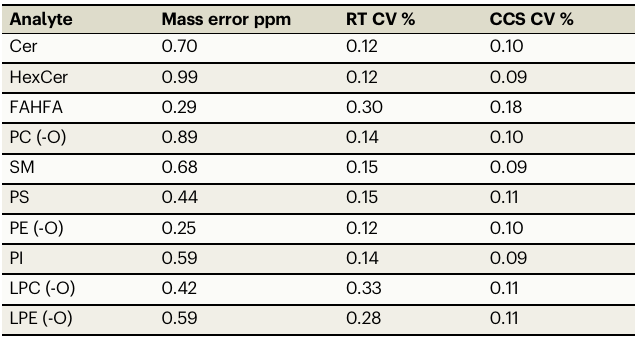
Table 2 | Inter-assay reproducibility NIST plasma SRM auto- mated extraction Analyte Mass error